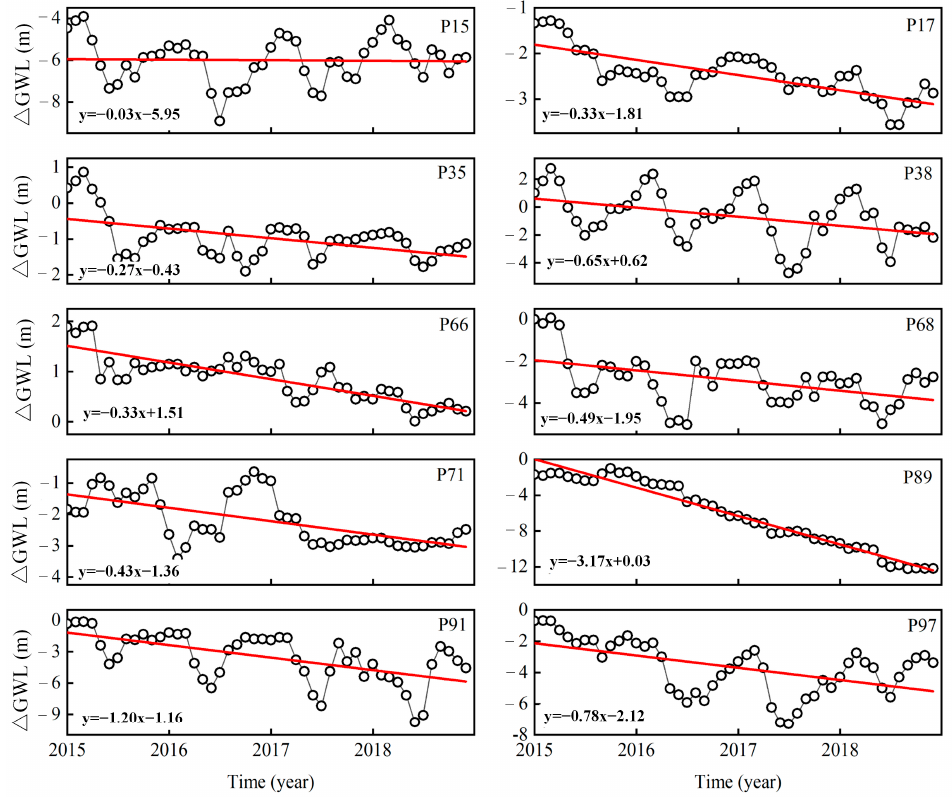
Figure 5. The GWL changes of ten downtrend wells during 2015–2018.